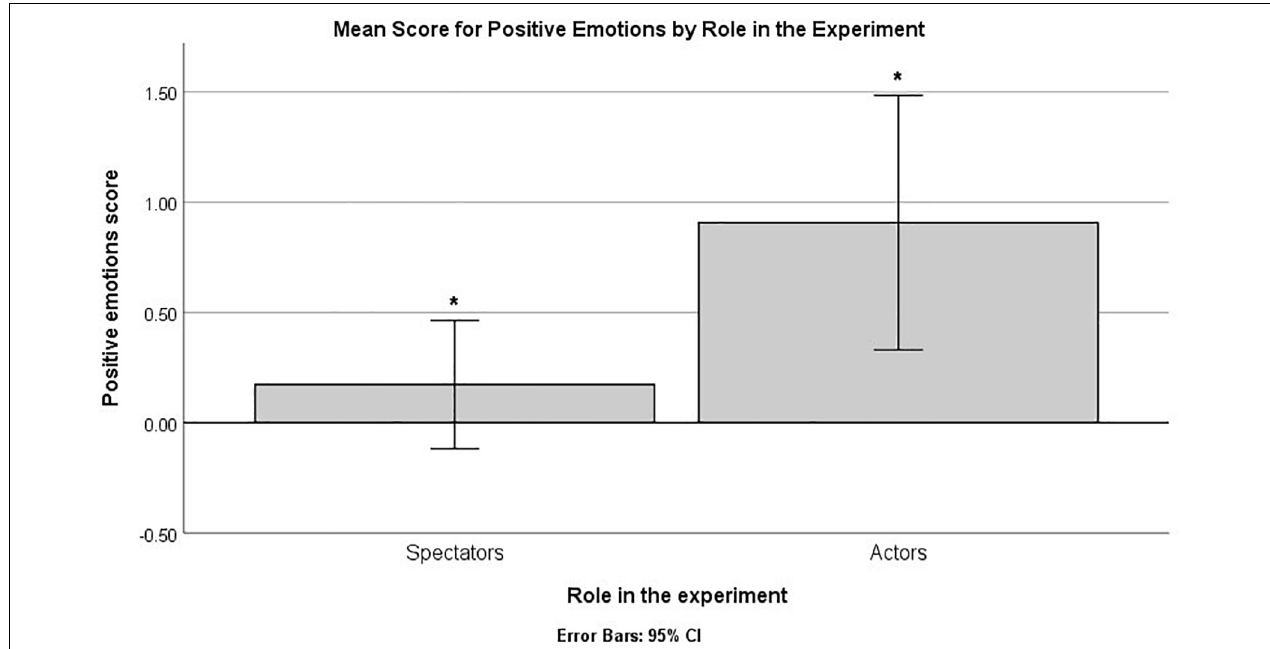
FIGURE 3 | Mean frequency for positive emotions by role in the experiment (item 3). The bars marked by “ ∗ ” indicate statistically significant differences based on a non-parametric analysis and B–H procedure for controlling false discovery rate (FDR).